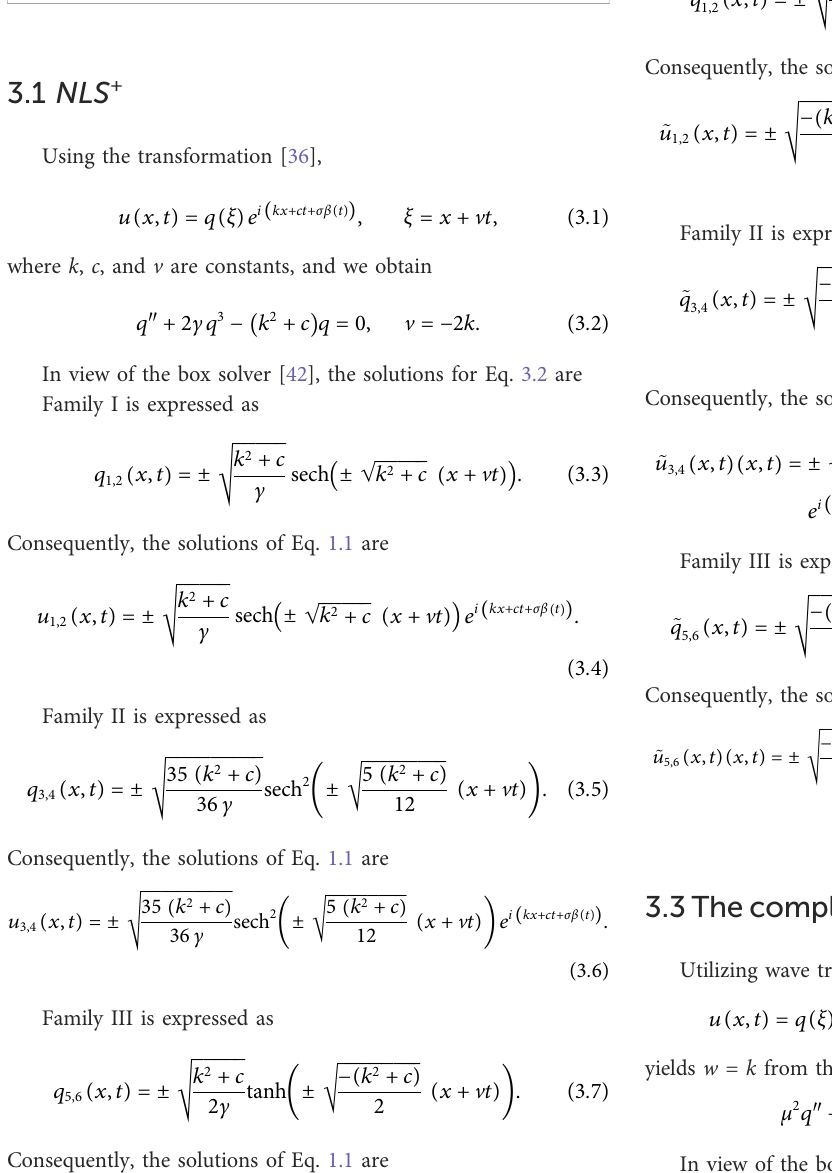
FIGURE 10 3Dplotforsolution(3.22)with k =0.6, α =0.3, δ =0.5, c =2.8,and ρ =